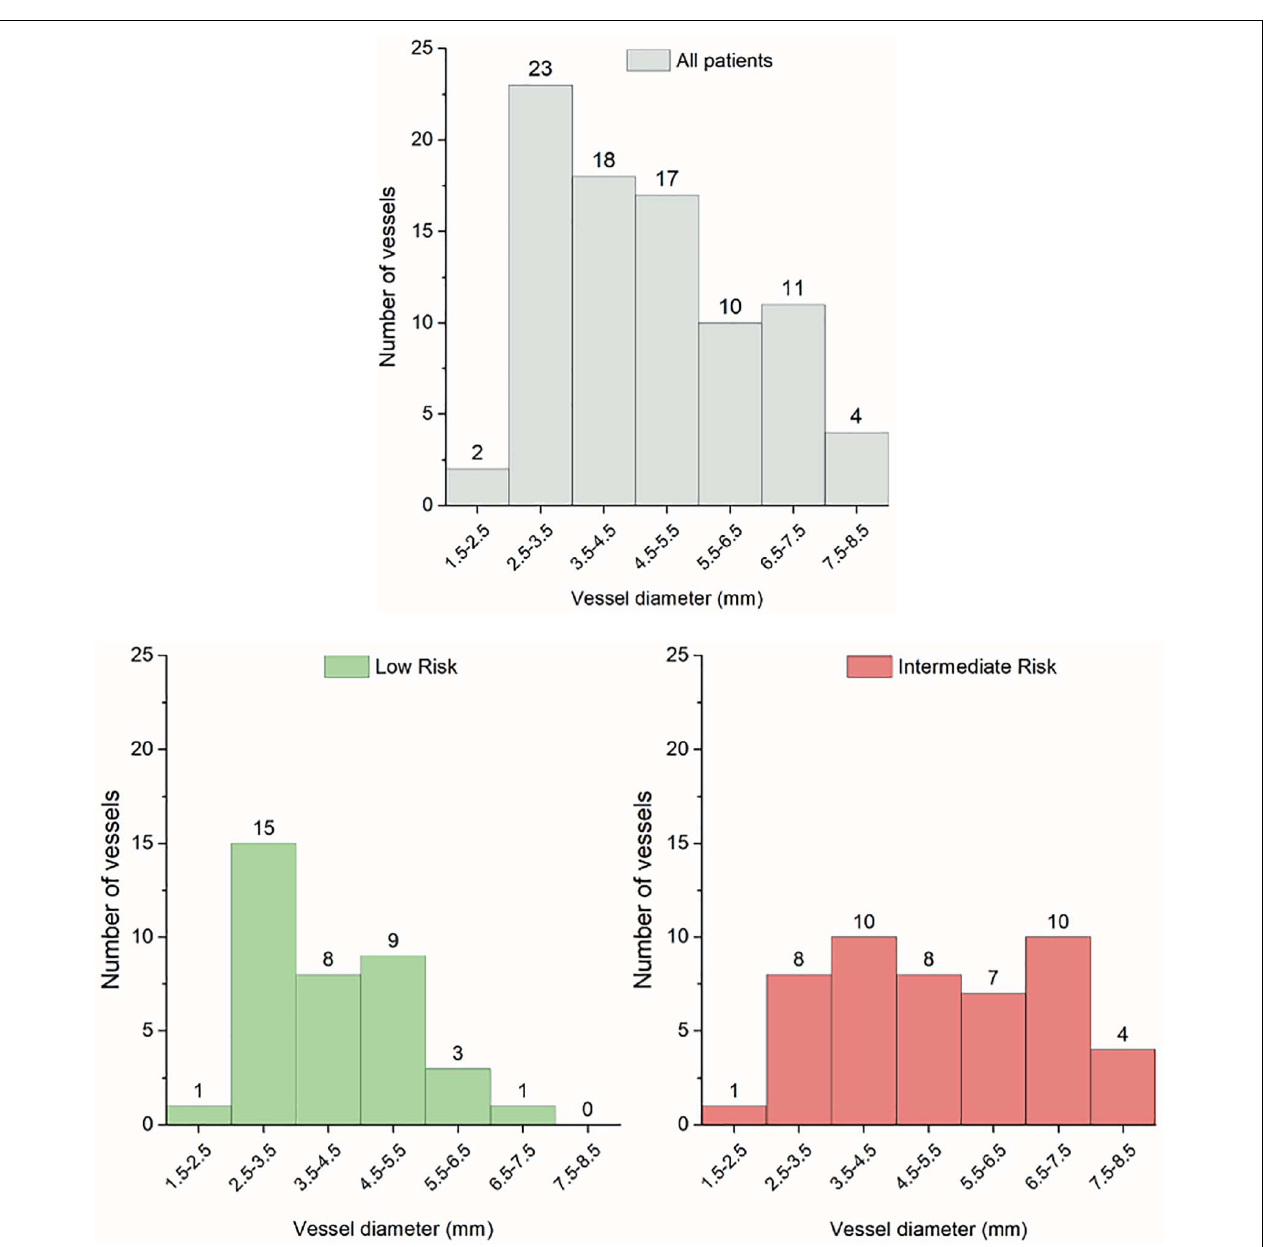
FIGURE 3 | Histograms of the pulmonary artery segments from all patients ( n = 85), low-risk ( n = 37) and intermediate-risk patients ( n = 48).